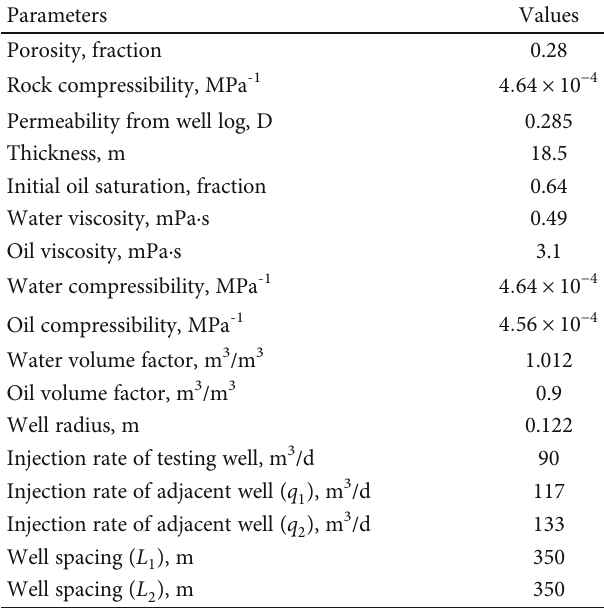
Figure 17: E ff ect of well spacing on pressure transient response. L and L are well spacings. 2 Table 2: The basic parameters of a fi eld